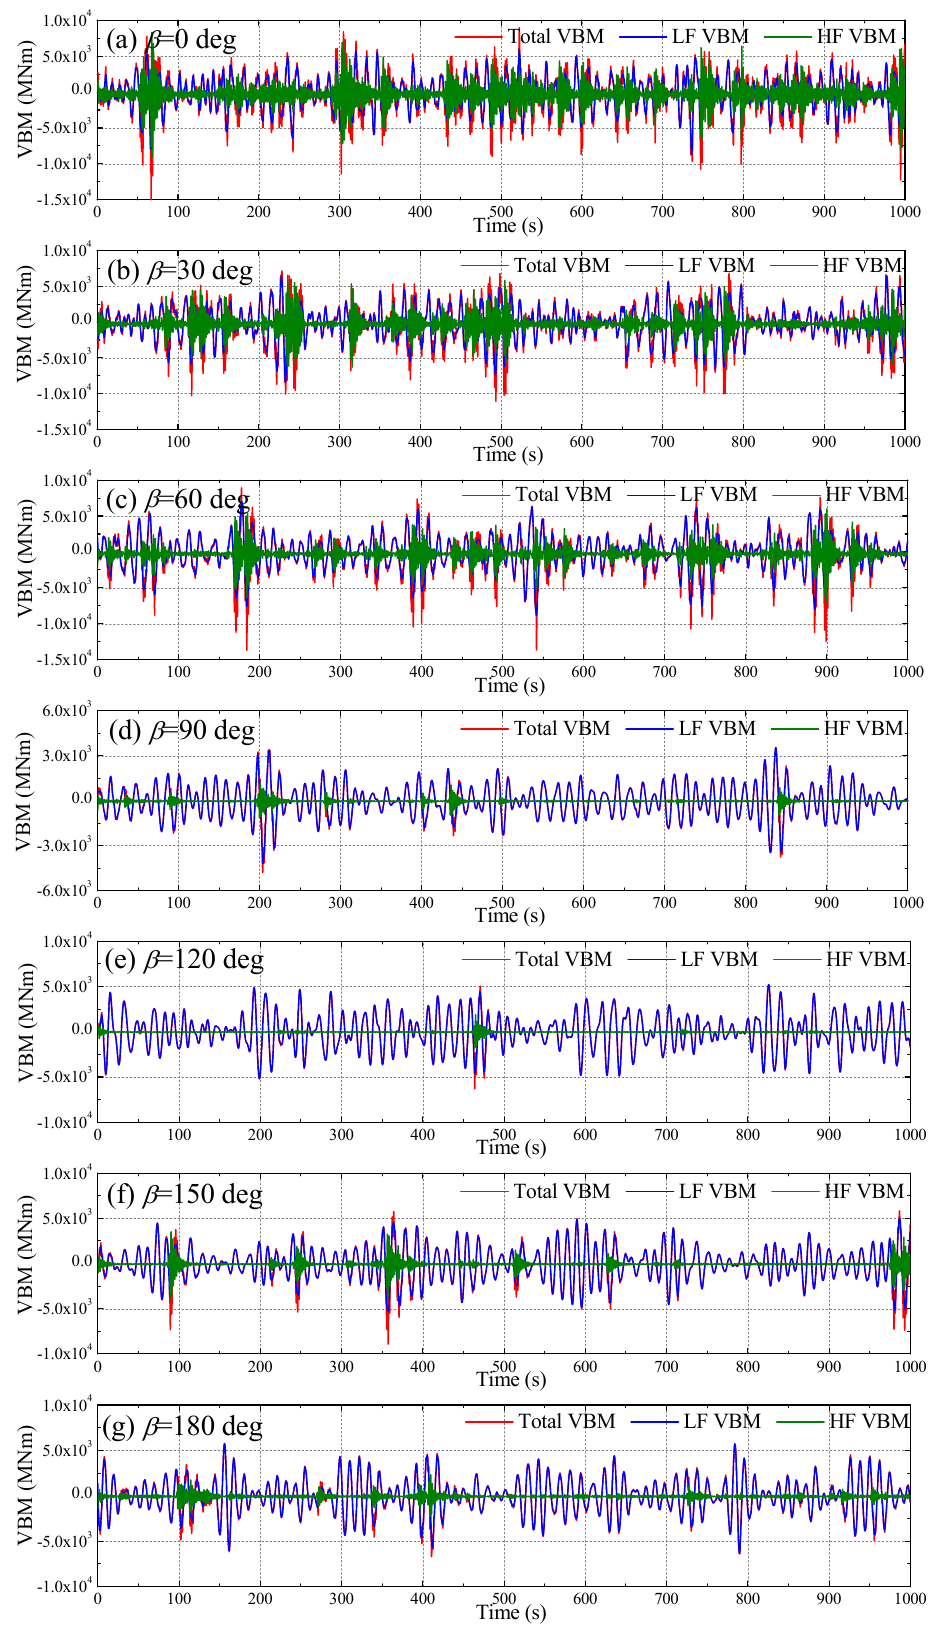
Figure 19. VBM load components in different wave